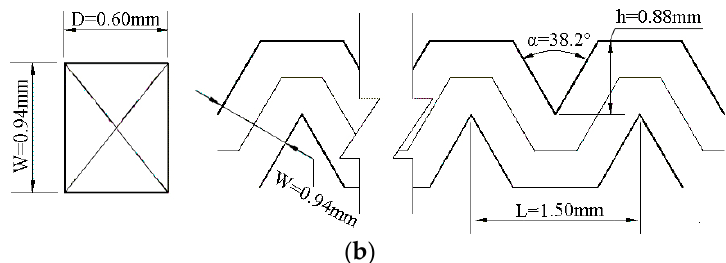
Figure 1. Emitter used in drip tape. ( a ) Labyrinth-channel emitter; ( b ) parameters of the flow path in the emitters. W, tooth space width; D, depth; α , angle of the bevel edge and baseline; L, tooth space width; h, tooth height.